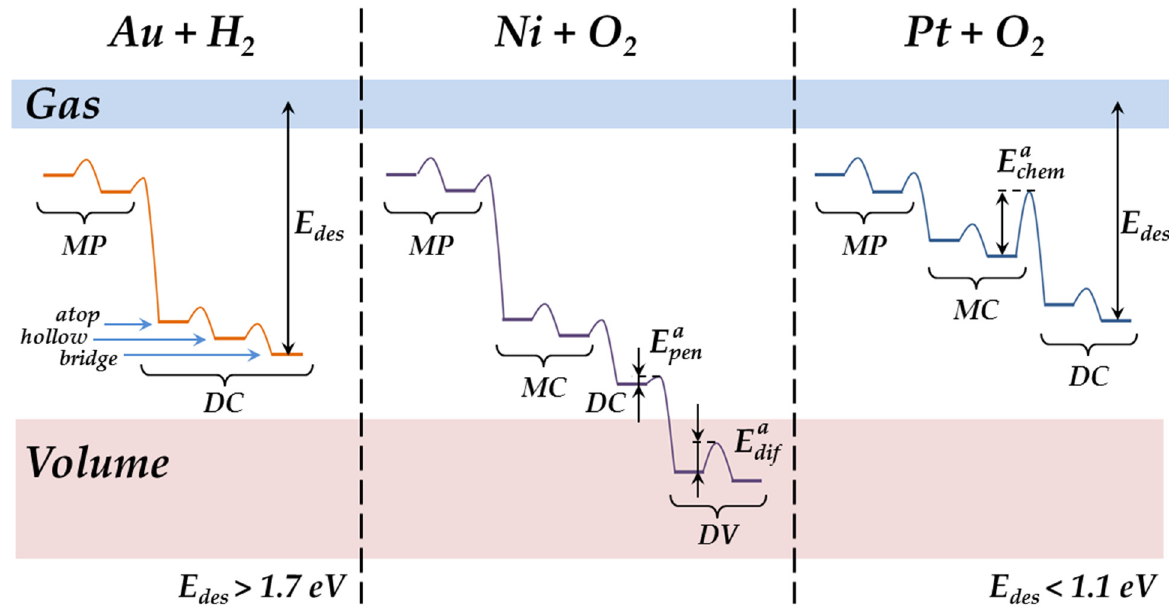
Figure 11. Simplified energy diagram of the processes taking place on the surfaces of gold, nickel, and platinum nanoparticles while interacting with gas molecules: MP—molecular physisorption, MC—molecular chemisorption, DC—dissociative chemisorption, DV—diffusion in volume.